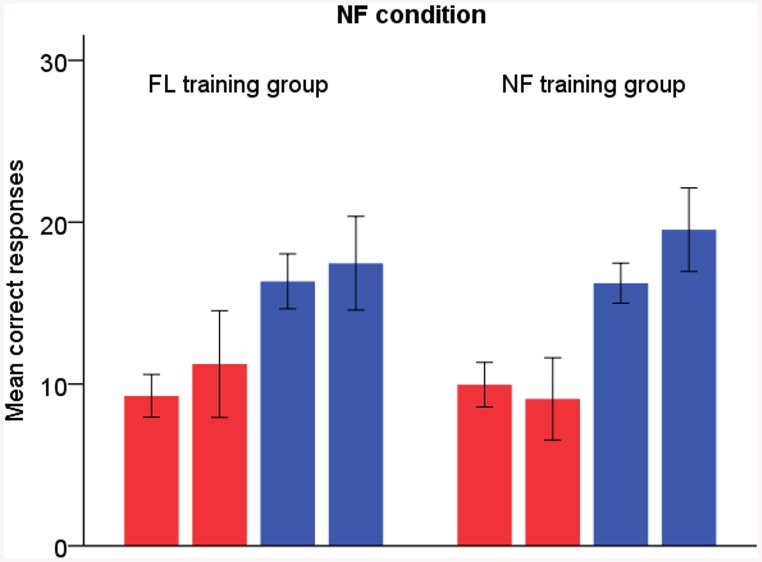
NF condition.Red bars = left-ear responses, blue bars = right-ear responses. The left-sided bar of each two bars of the same colour represents pre-training results and the right-sided bar post-training results. Error bars display 95% confidence interval for mean.